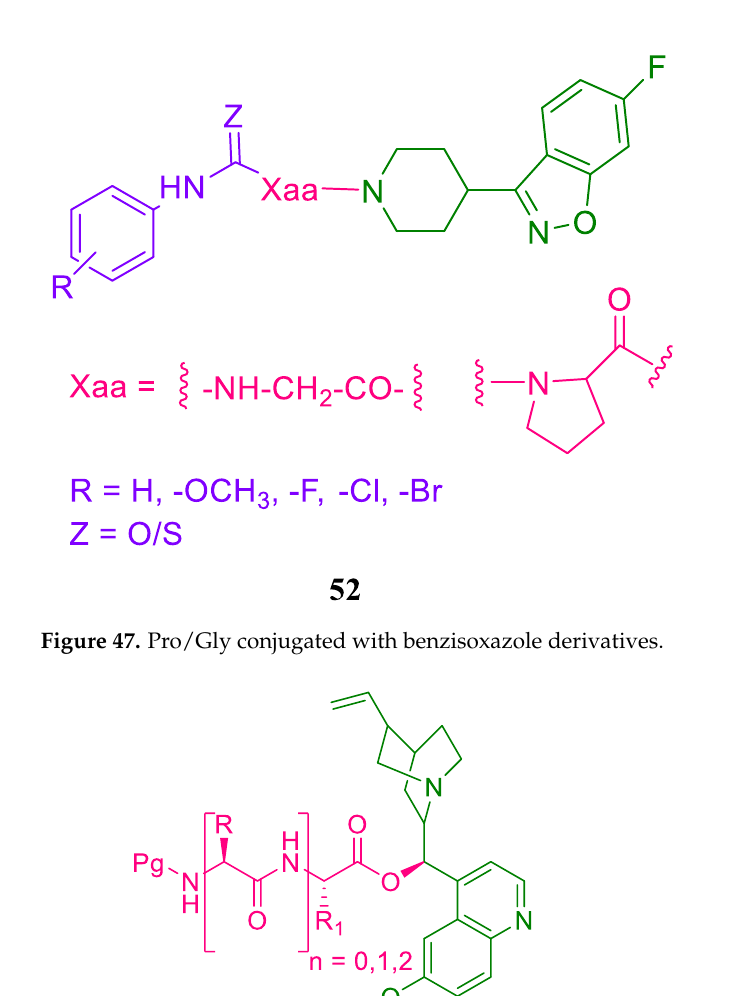
39 of 90 Figure 46. Quinazolinone conjugated to shorter analogues of Bactenecin 7. Shantharam C S et al. synthesised a novel series of thiourea/urea analogues of Pro- /Gly-conjugated benzisoxazole derivatives ( 52 ). In the series, some of the compounds were highly potent antiglycating agents due to the presence of urea and thiourea ana- logues (Figure 47). The compounds containing -OCH 3 and -Br were recognised as active compounds, which hindered the glycation with IC 50 values of 3.6 ± 0.3 µM and 6.3 ± 0.8 µM, respectively. Comparatively, the compounds containing Pro showed less activity than the Gly-containing moieties, which may be due to the simple nature and small size of Gly, which could have increased the binding properties. Among urea and thiourea de-